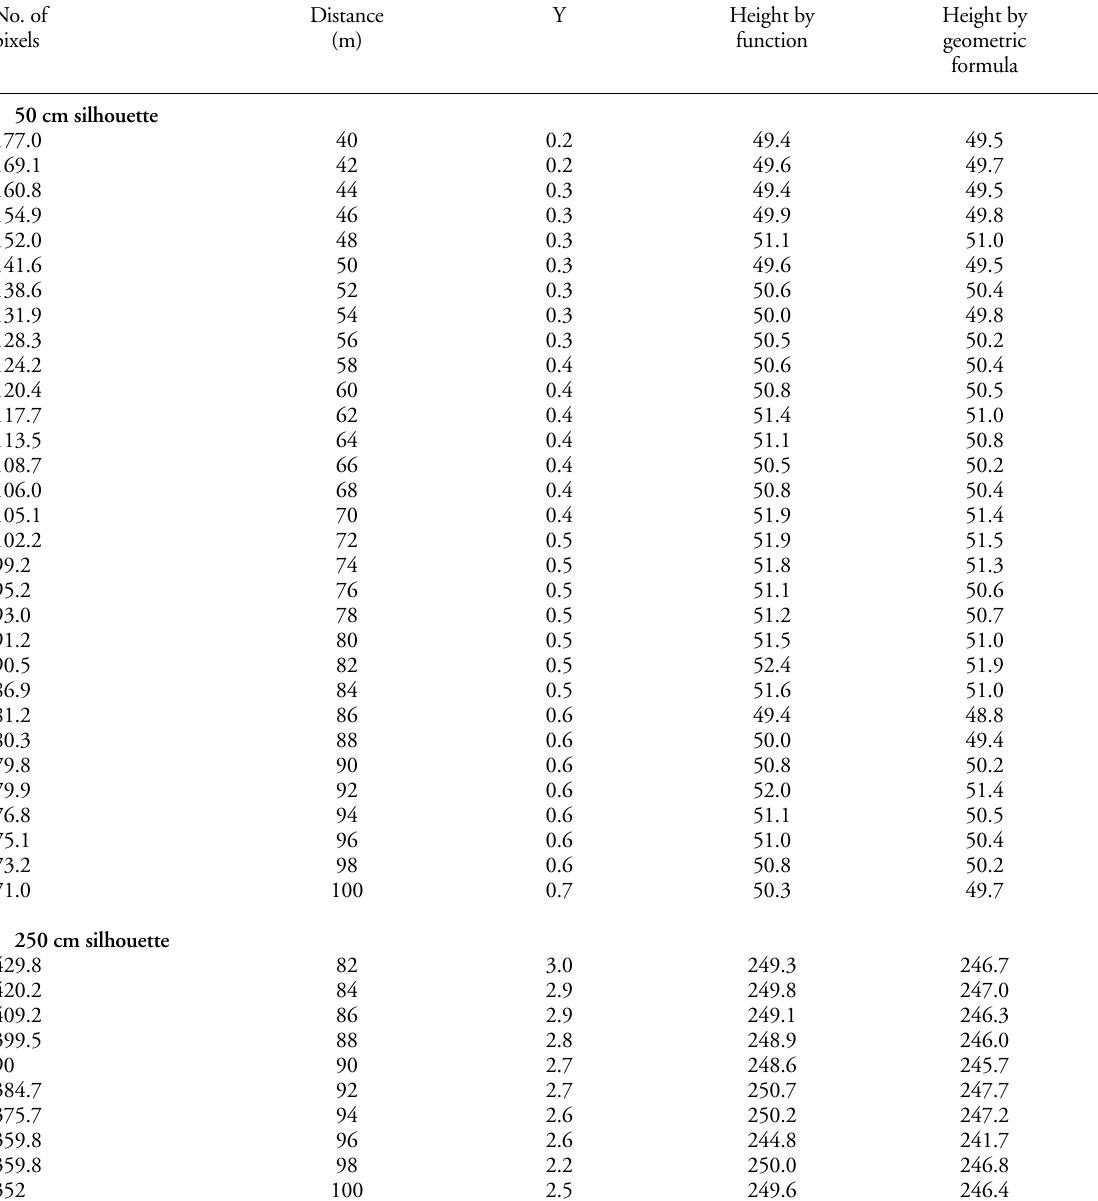
Table 2. Comparison of performance of the two methods used for the estimation of shoulder height of differently sized elephant silhouettes (50 cm and 250 cm